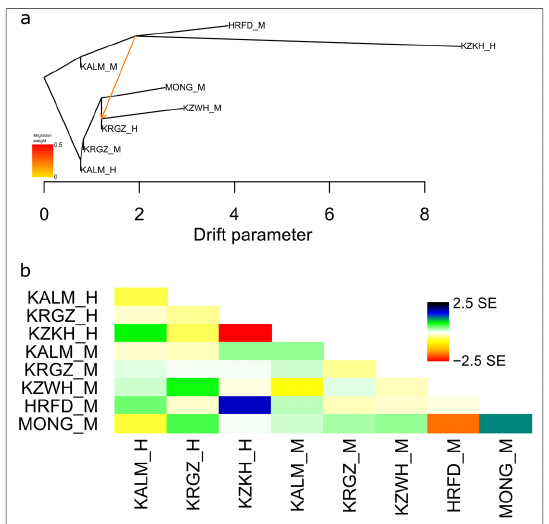
Figure 4. ( a ) Maximum likelihood tree inferred from studied cattle populations with single migration edge. Scale bar shows 10 times the average standard error (SE) of the estimated entries in the sample covariance matrix. Putative gene flow is indicated by the arrow, pointing in the direction of flow from the donor to the recipient population, and coloured in orange, proportional to the gene flow intensity. ( b ) Residual matrix plotted from a TreeMix analysis under single migration event and expressed as the number of SE of the deviation. Positive SE values between pairs of populations indicate that populations are more closely related to each other than in the modeled tree, while negative SE values show that the observed covariance is overestimated. Museum populations: